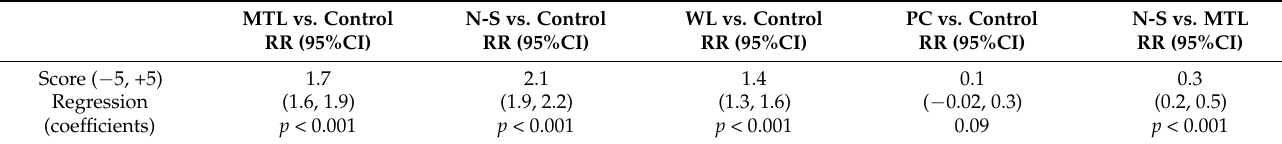
Table 5. Multiple regression analysis results—association between global food score and FOPL group (adjusted for design factors and covariates as planned).